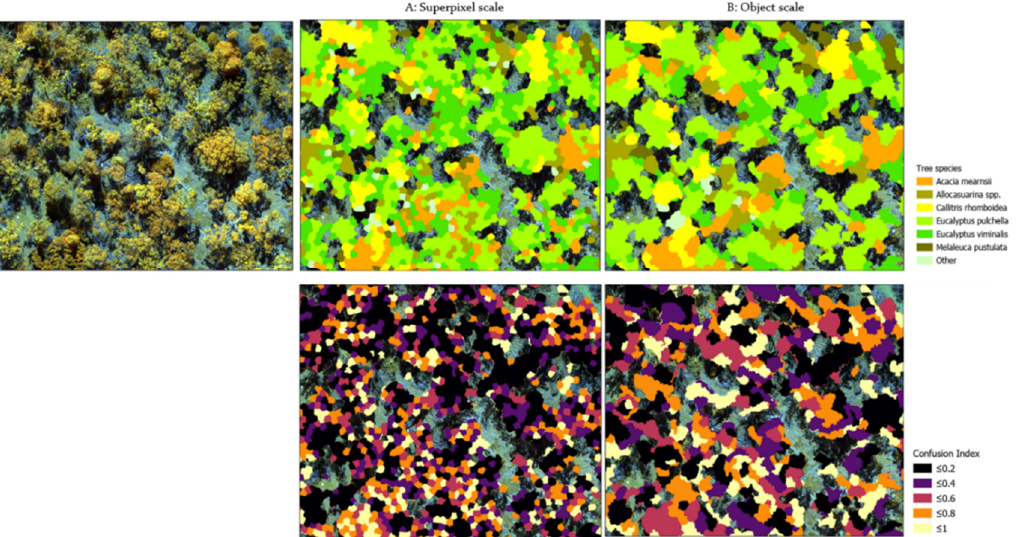
Figure 11. Predicted class and Confusion Index at the superpixel ( A ) and object ( B ) scales. Although classification accuracies were high (0.84 with superpixel, 0.77 at object scale), the Confusion Index was high, indicating high uncertainty in the predictions. This low confidence was not specific to a particular class or to locations in the canopies. This uncertainty is likely due to the spectral similarity between the tree species, and perhaps highlights the need for additional reference data, or input features to improve confidence in the predictions.